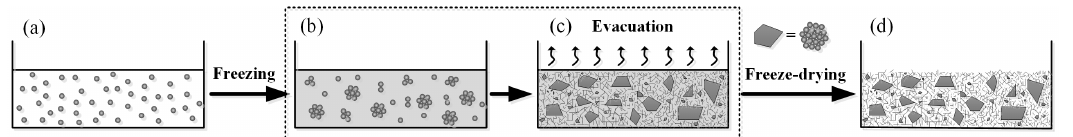
Figure 4. Schematics of the formation mechanism of the colloidal crystals in our method. (a) Well dispersed colloidal suspension; (b) precipitation of the nanoparticles; (c) colloidal crystal grains dispersed in solid water; (d) porous block comprising of colloidal crystal grains after the removal of solid water.